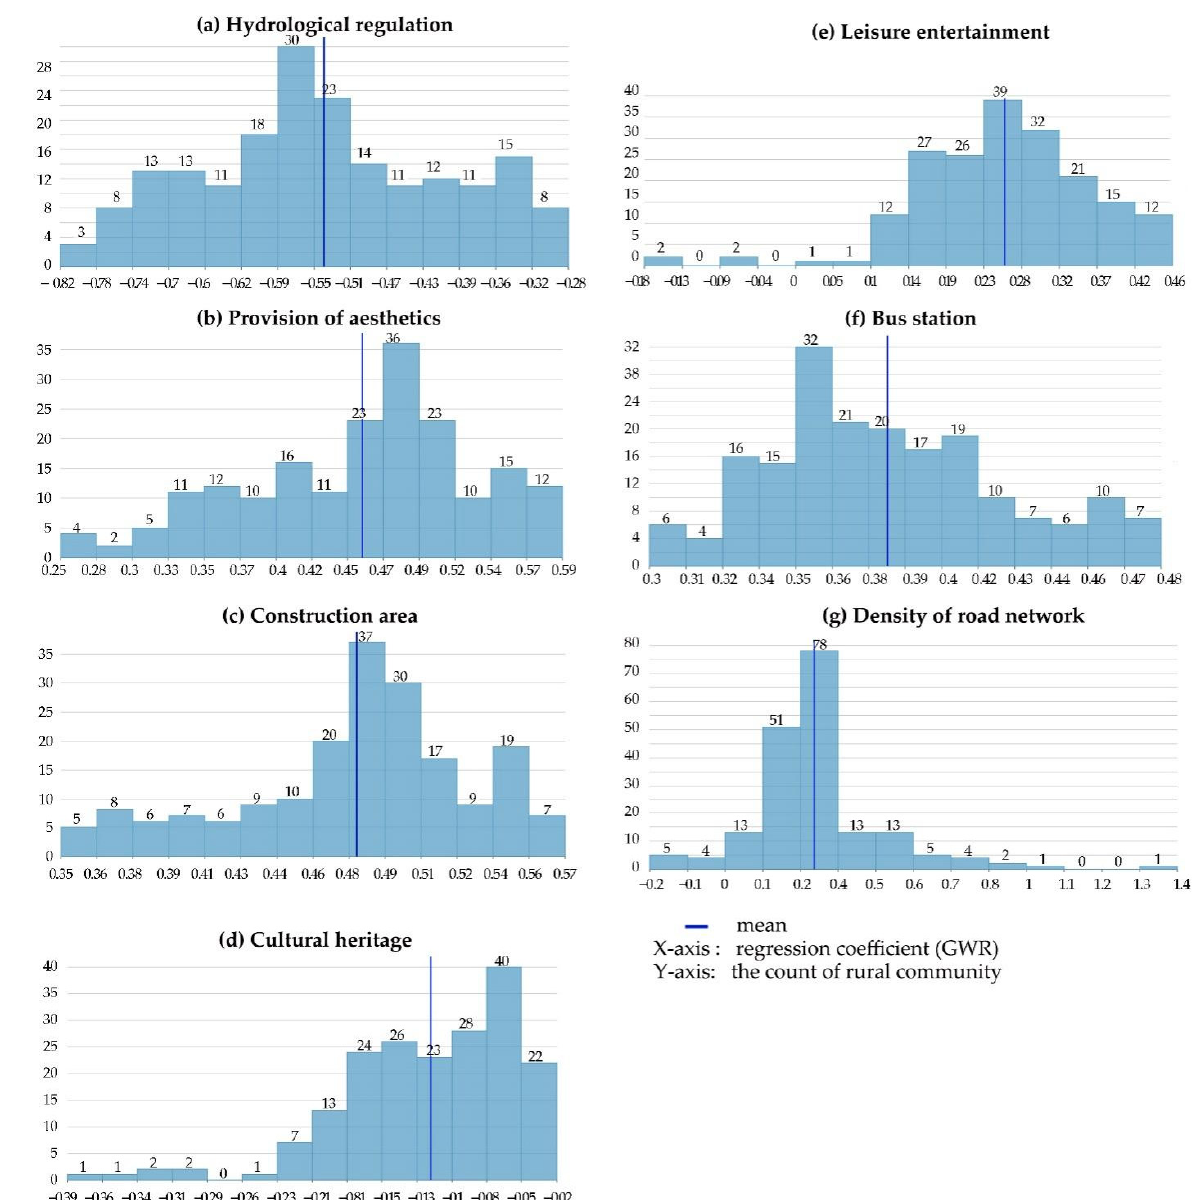
Figure 8. The histogram of regression coefficients between human activities and the factors of LFs, ( a ) The histogram of hydrological regulation, ( b ) The histogram of provision of aesthetics, ( c ) The histogram of construction land, ( d ) The histogram of cultural heritage, ( e ) The histogram of leisure entertainment, ( f ) The histogram of bus station, ( g ) The histogram of density of road network.